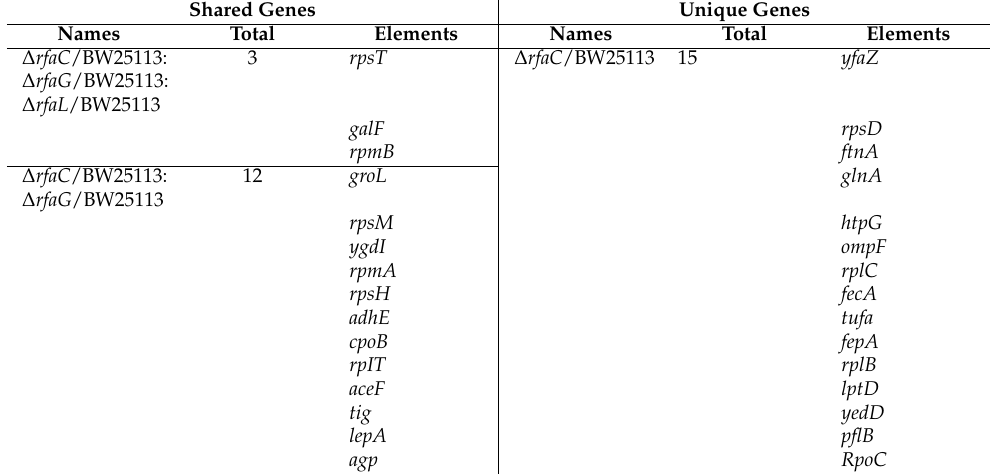
Table 2. Unique and shared genes between ∆ rfaC /BW25113: ∆ rfaG /BW25113: ∆ rfaL /BW25113. Shared